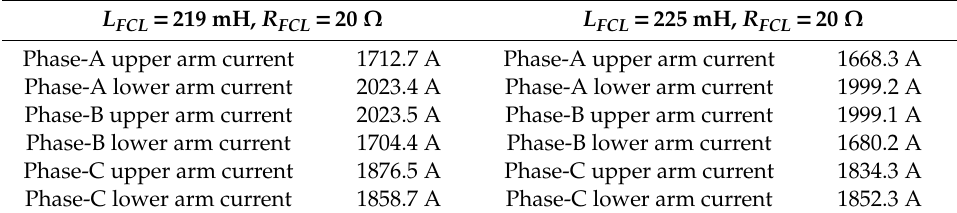
Table 3. Arm currents under the calculated and simulated L FCL _ min